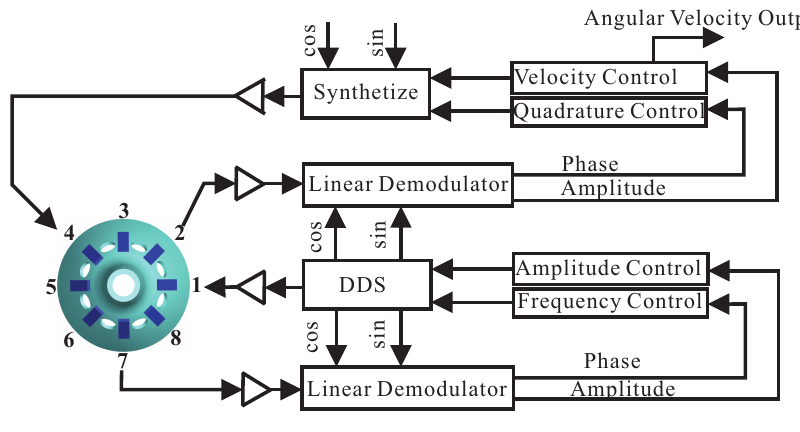
Figure 13. Schematic of the signal